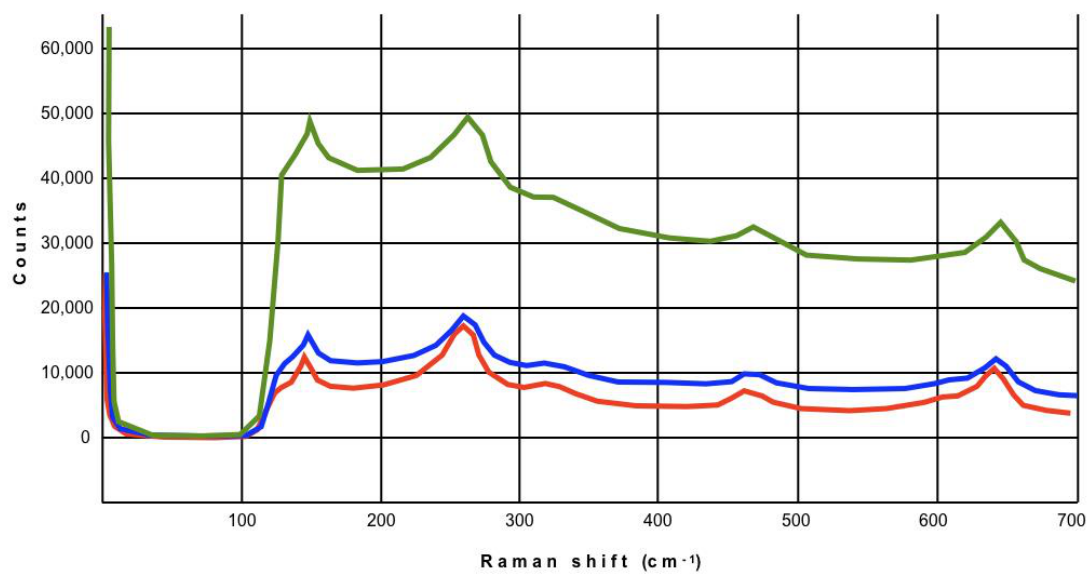
Figure 5. Representative Raman spectra obtained on slight-chamfer, deep-chamfer, and knife-edge finish lines. No monoclinic zirconia bands are visible (arrow indicates areas where they should occur).